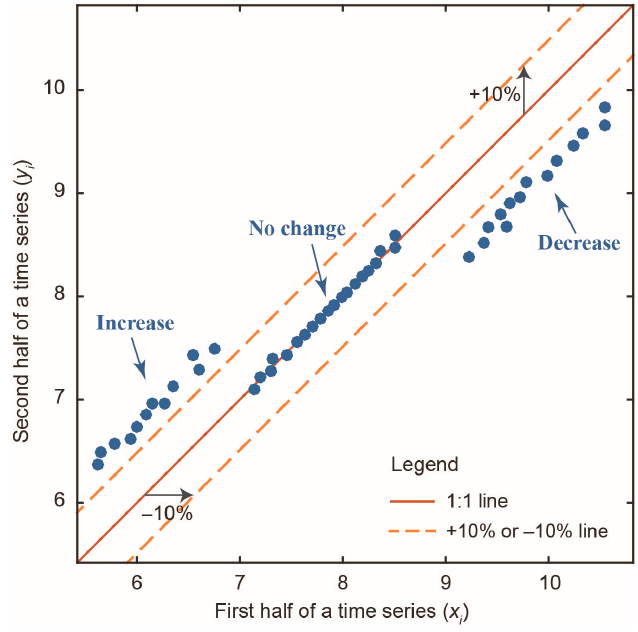
Figure 2. Illustration of the Partial Trend Method (PTM) plot for increasing, decreasing and no change regions.